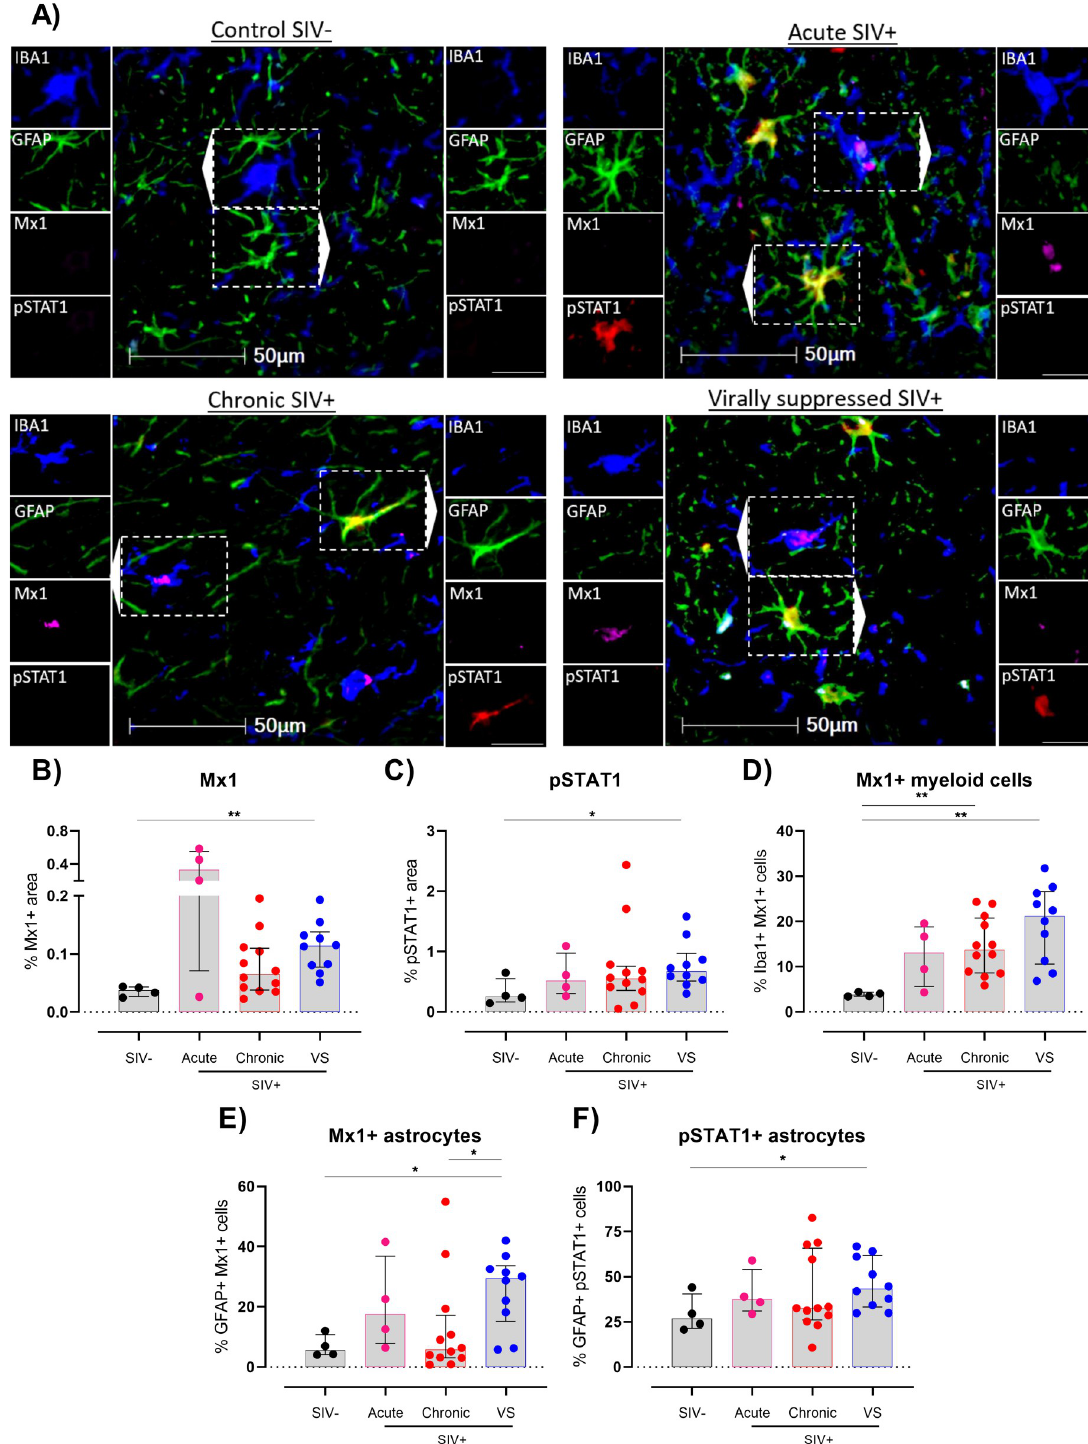
Fig 2. Chronically ART-suppressed SIV+ rhesus macaques show activated type I interferon responses in the frontal cortex of the brain. (A) Representative images of multiplex fluorescent immunohistochemistry performed on frontal cortex tissue of untreated, virally suppressed (VS) or uninfected controls for detection of Iba1 (myeloid cells), GFAP (astrocytes), pSTAT1 and Mx1. Images shown at x30 magnification; scale bars: 50 μ m and 25 μ m (single channel inset). (B) Percentage of Mx1+ area, (C) pSTAT1 area, (D) Iba1+ Mx1+ cells as a percentage of total Iba1+ cells, (E) GFAP+ Mx1+ cells as a percentage of total GFAP+ cells or (F) GFAP+ pSTAT1+ cells as a